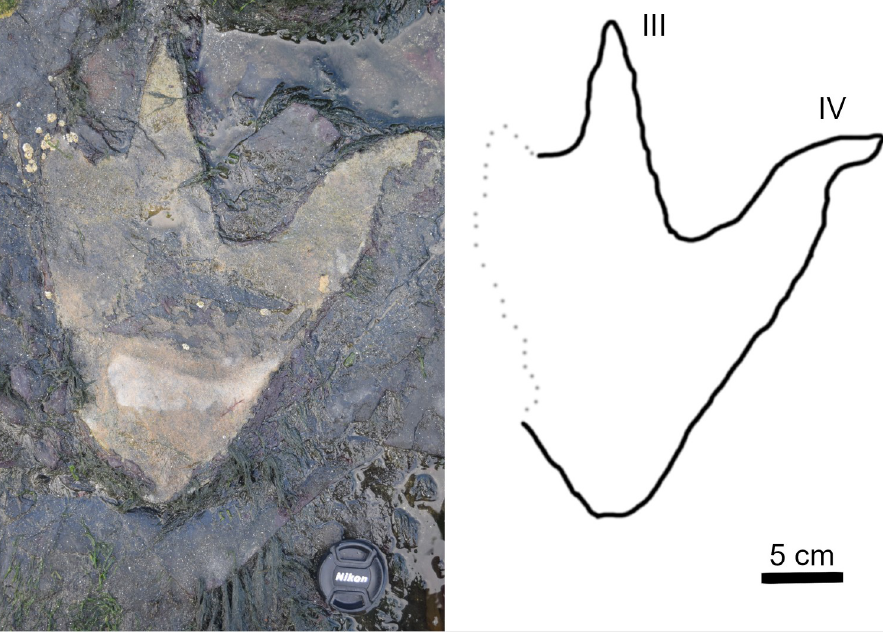
Fig 12. Exemplar track BP1_30. A field photograph and corresponding outline drawing showing the distinctive limestone cast infilling the impression of BP1_30, the most clearly defined track in TA_1. The strong color contrast between the rock types serves to accentuate the shape details of the track including the narrow, pointed digits and the elongated heel.